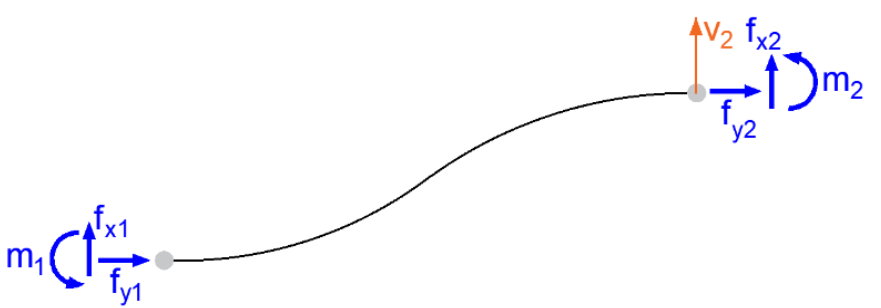
Figure 7. Displacement of point 2 in horizontal direction.